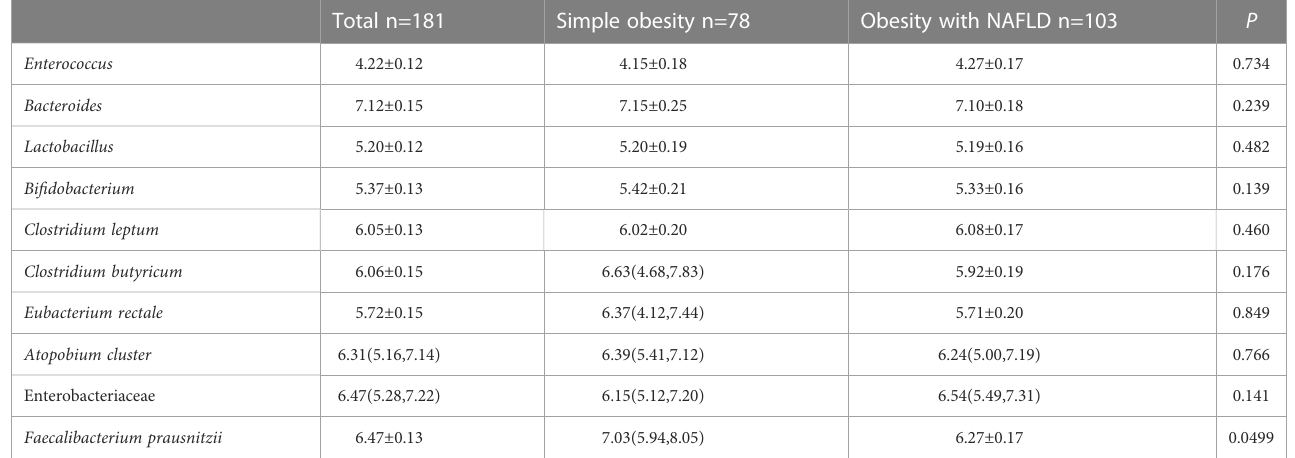
TABLE 2 Comparison of the gut dominant microbiota in two groups of obesity with NAFLD and simple obesity.